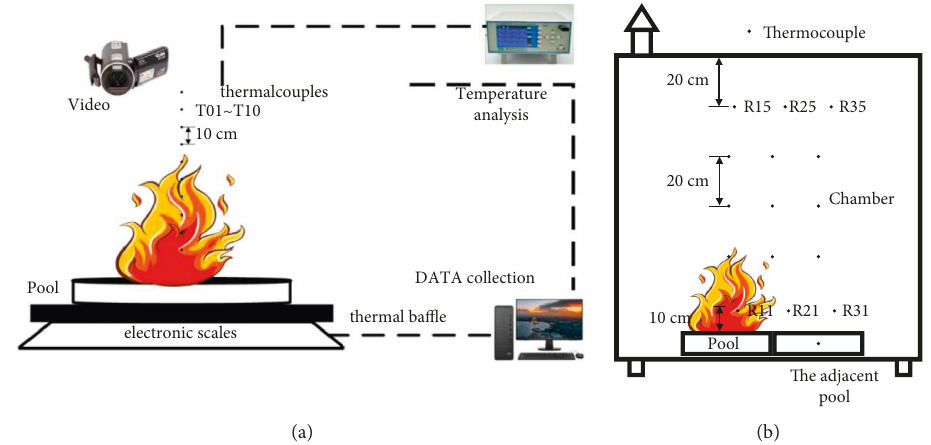
Figure 1: Schematic diagrams of the experimental setup. (a) For open space. (b) For confined space. Table 1: Thermophysical parameters of Kunlun transformer oil KI25X. Pour